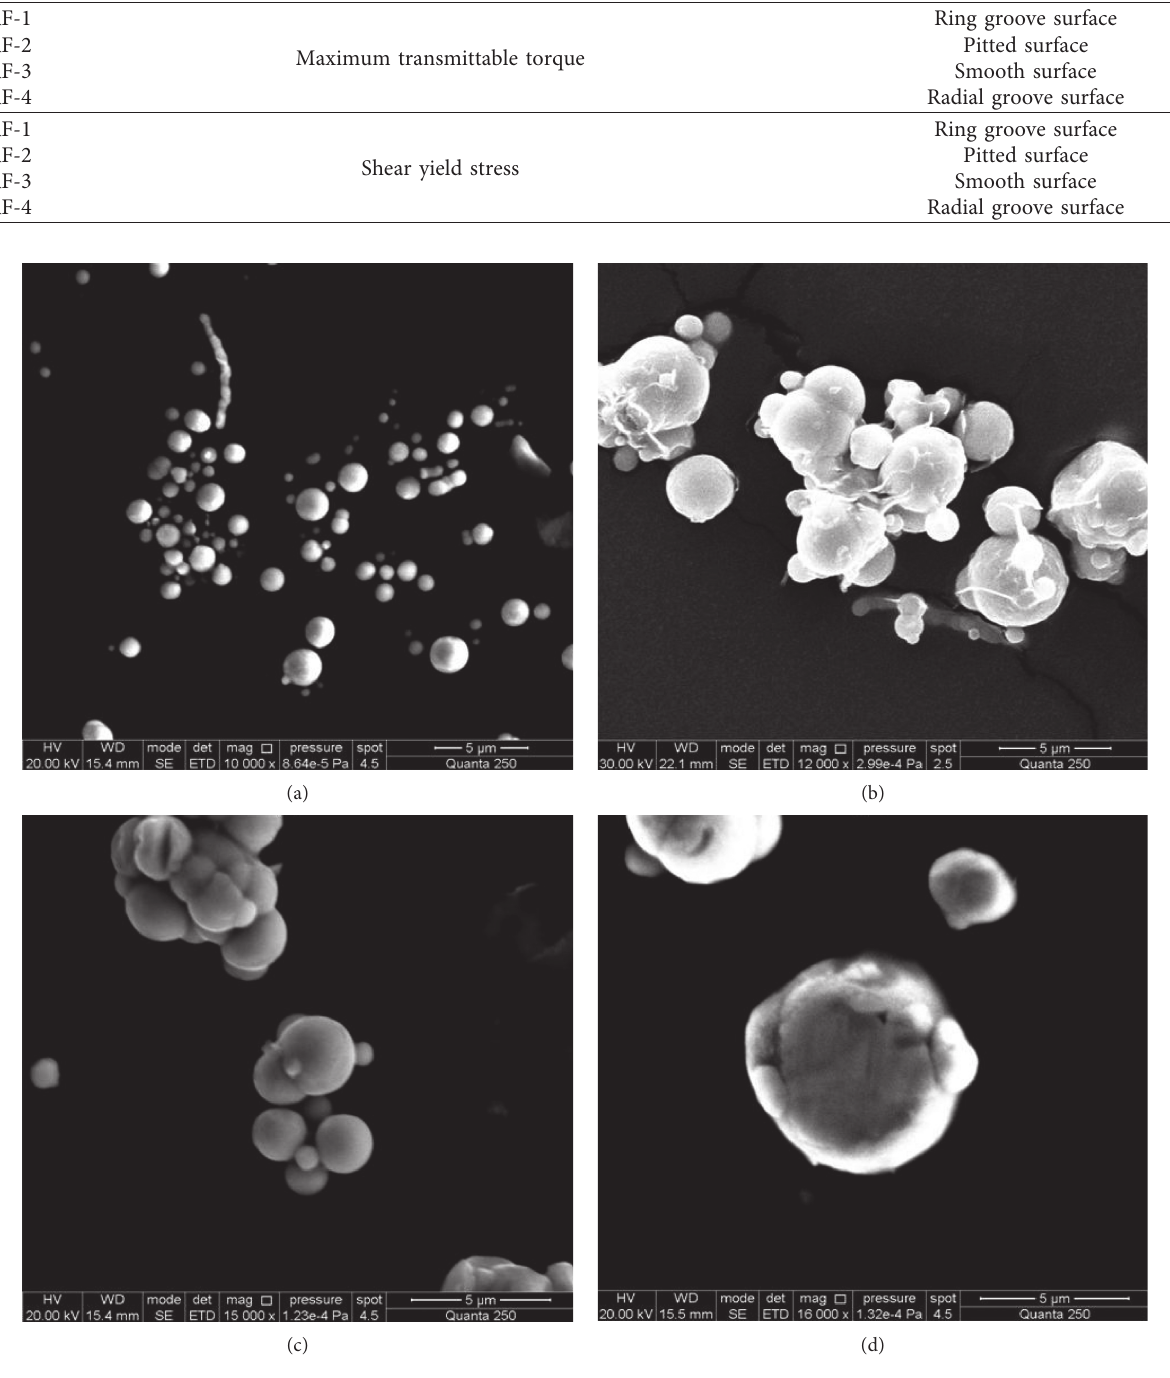
Figure 9: (a) SEM images of magnetic carbonyl iron particles. (b) Modified particles of MRF before experimental test. (c) Multiple particles of MRF after experimental test. (d) Particles of MRF after experimental